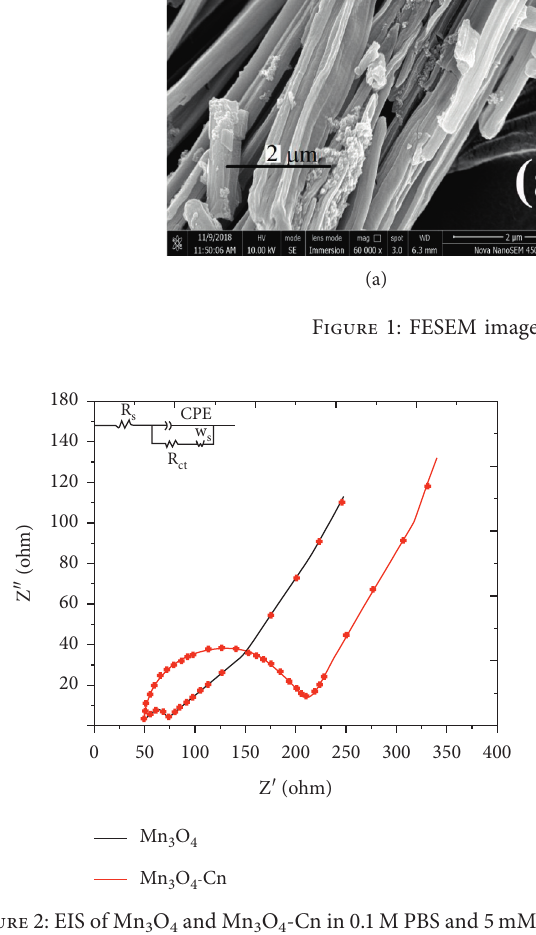
Figure 2: EIS of Mn 3 O 4 and Mn 3 O 4 -Cn in 0.1M PBS and 5 mM Fe (CN) 6